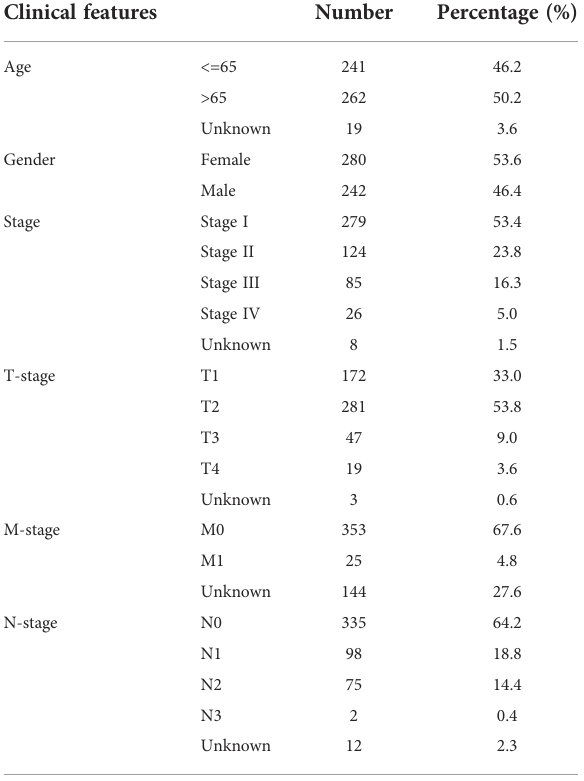
TABLE 1 Baseline information of patients in TCGA.